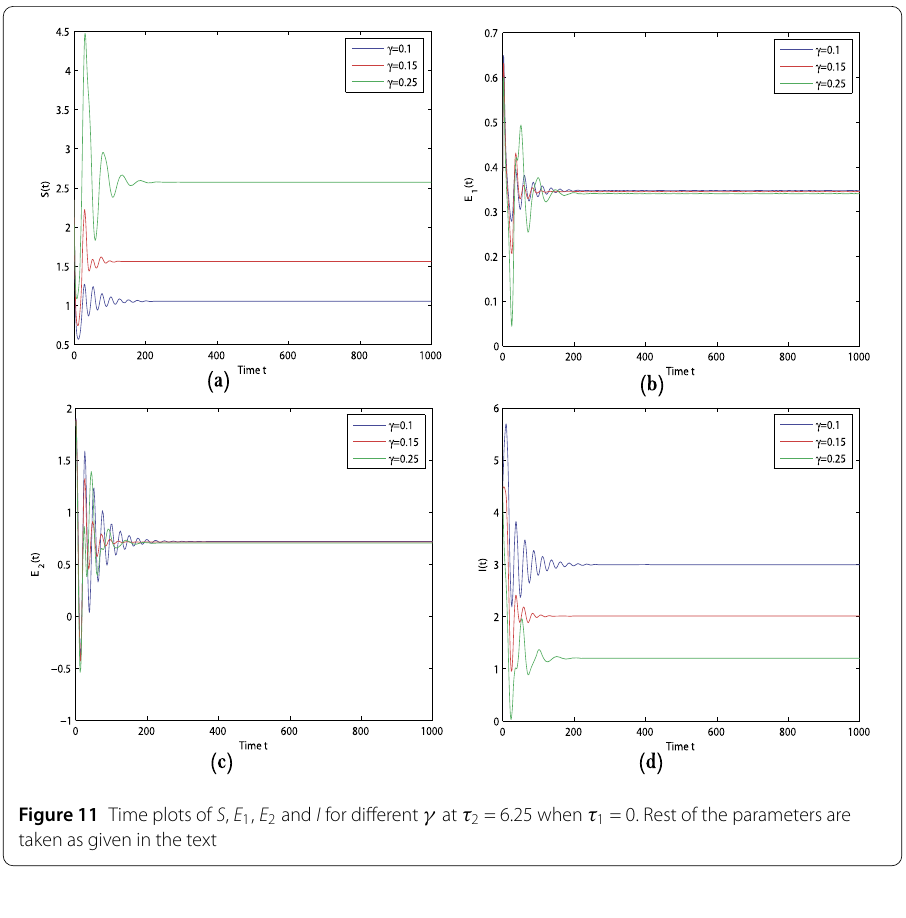
Figure 12 Dynamic behavior of system (26): projection on S – E 1 – I with τ 2 = 7.55 > τ 20 when τ 1 = 0 for different γ . Rest of the parameters are taken as given in the